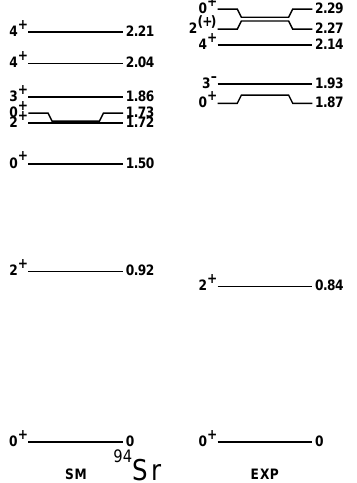
Figure 8. The same as in Figure 5, but for 94